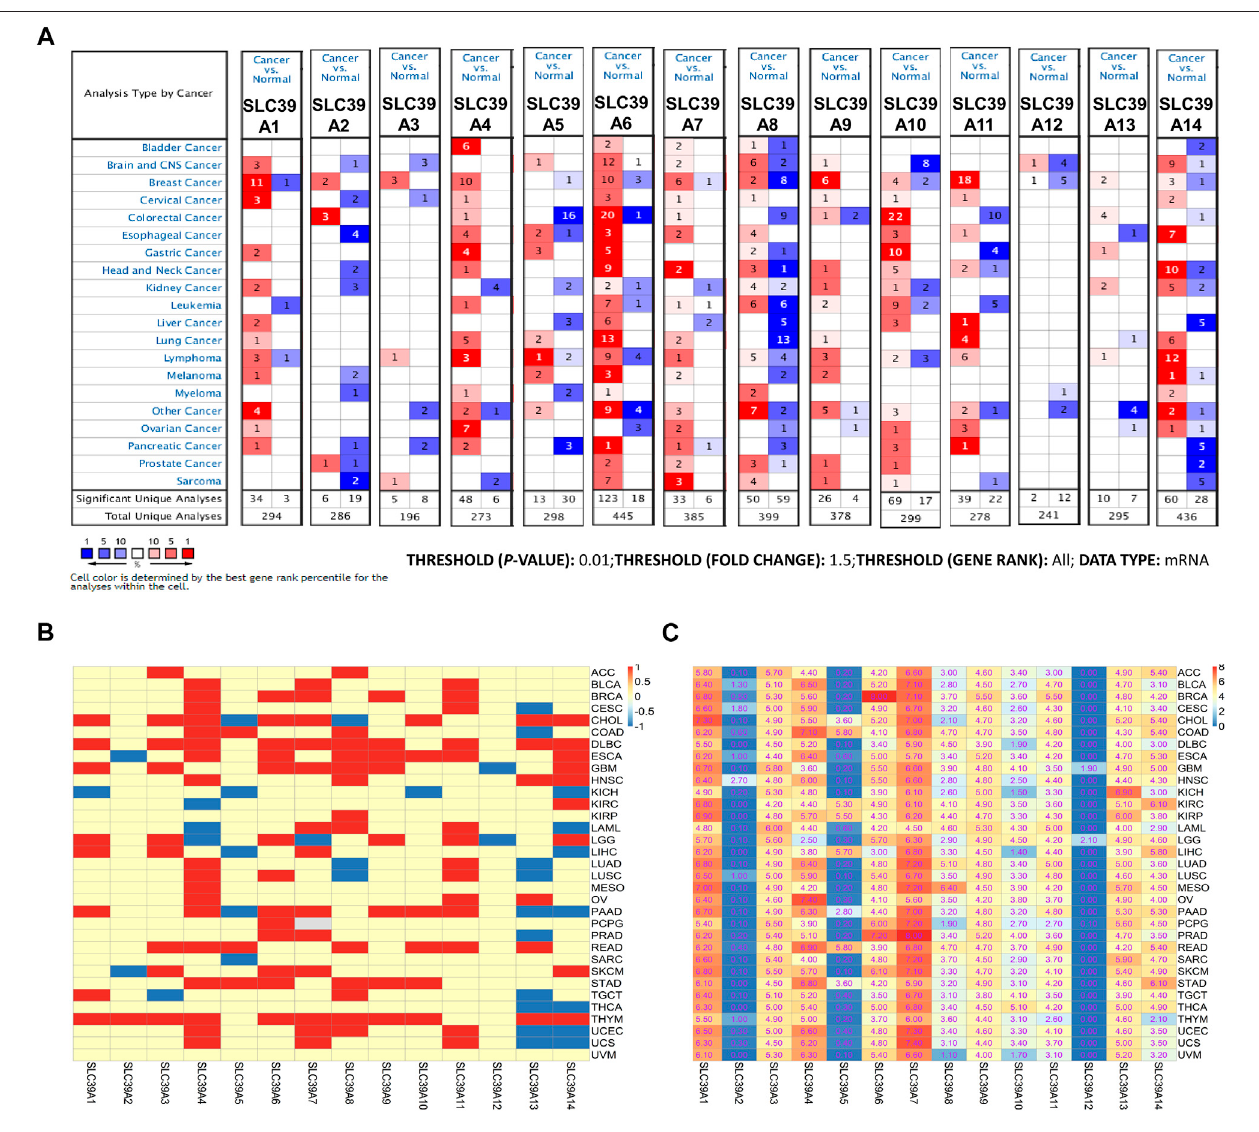
FIGURE 1 | mRNA expression pro fi les of the SLC39A family genes in pan-cancer. (A) Transcriptome expression pro fi le of SLC39A family members in pan-cancer was explored in the Oncomine database. In the graph, red represents statistically signi fi cant mRNA overexpression of SLC39A family gene mRNA between the tumor and thecorrespondingnormaltissue, bluerepresentsdown-expression,and the number represents the number ofdata sets. p valueissetto0.01; foldchange isset to 1.5; gene level is set to all; and data type is set to mRNA in the Oncomine database. (B) Transcriptome expression pro fi les of SLC39A family genes in pan-cancer were explored in the GEPIA database. The red boxes represent higher SLC39A family gene expression in tumor tissues, while the green boxes represent the lower SLC39A family gene expression in tumor tissues. The inspection standard is set to p -value < 0.05. (C) Expression level of SLC39A family genes in 33 tumors and their normalcontrolsinthematchTCGAnormaland GTExdatausingGEPIA. Thedatainthe fi gurerepresentsaveragemRNAexpression of SLC39A family genesindifferent tumors. The colors from blue to red represent the range of values in the fi gure.